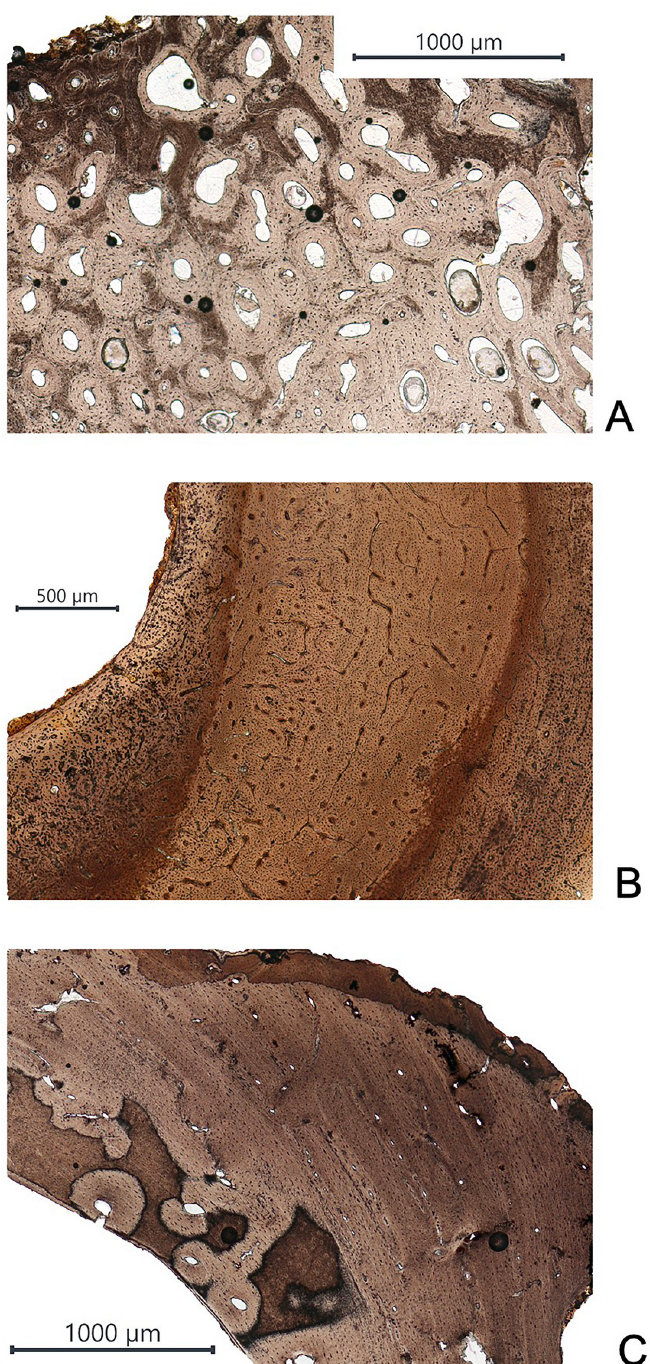
Fig 7. Comparison between thin sections in human and faunal specimens from the Tomb of Nestor’s Cup. (A) Thin section from the human specimen HIS-T(1); (B) thin section from the faunal specimen HIS-D(2); and (C) thin section from the faunal specimen